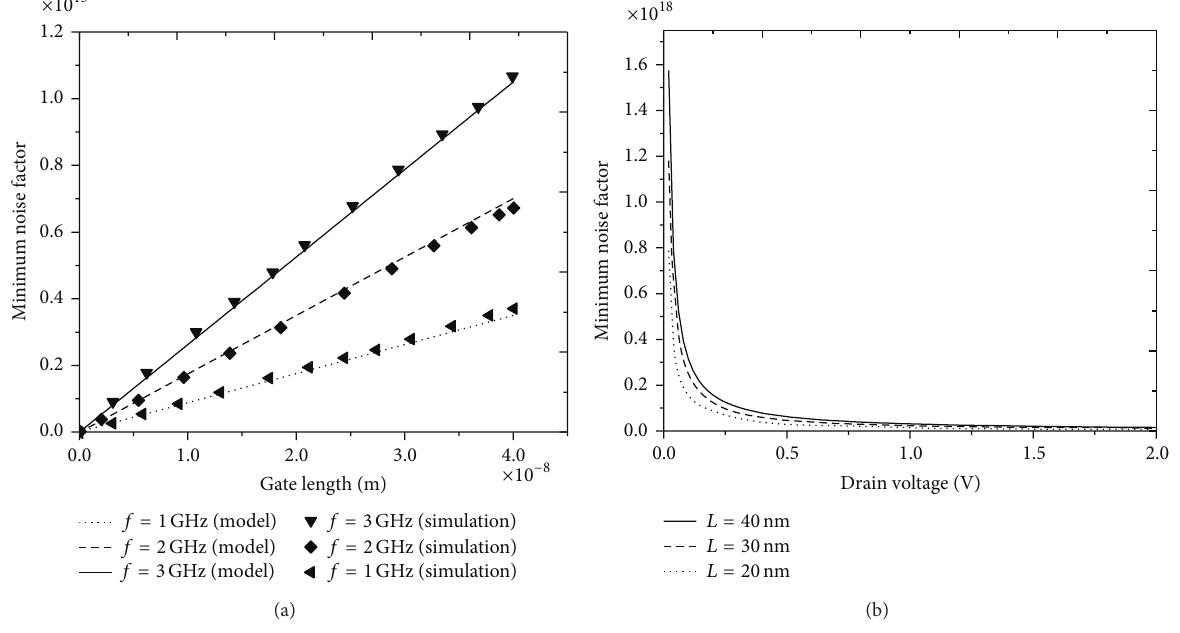
Figure 5: (a) Characteristic of minimum noise factor versus gate length. (b) Characteristic of minimum noise factor versus drain voltage.